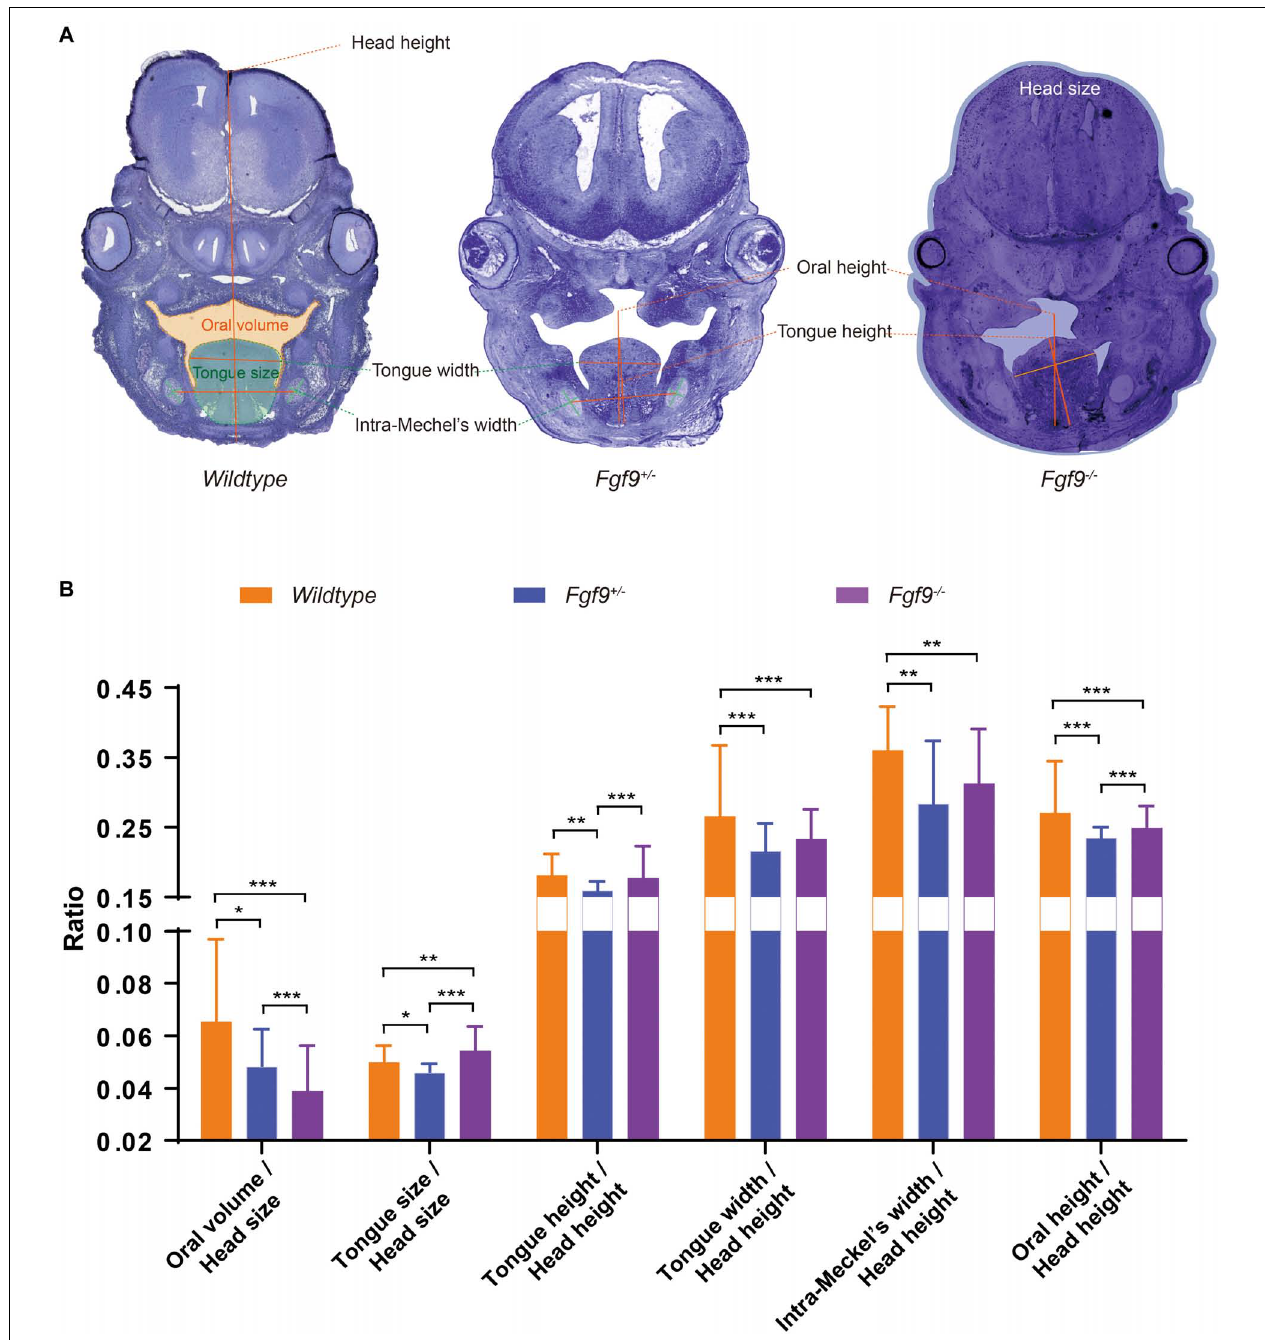
FIGURE 8 | Craniofacial morphometric measurements among Wildtype , Fgf9 + / − , and Fgf9 − / − embryos during palatal elevation. (A) Oral volume, tongue size, tongue height, tongue width, intra-Meckel’s width (distance between the bilateral centers of Meckel’s cartilages), and oral height based on selected serial sections of embryonic heads from three litters. Orange, green, and blue regions indicate the oral volume, tongue size, and head size, respectively. (B) Ratios of craniofacial morphometric parameters. * P < 0.1, ** P < 0.05, *** P < 0.001.